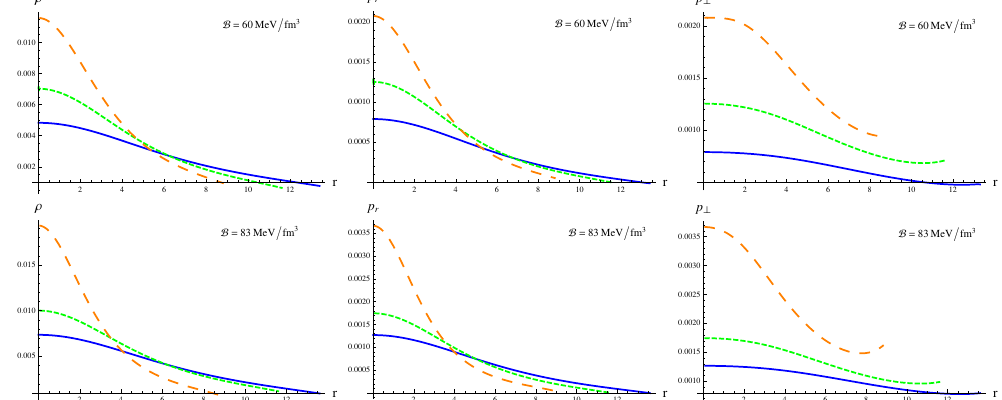
Figure 3. Matter variables (in km − 2 ) as functions of r (in km) with m Ψ =